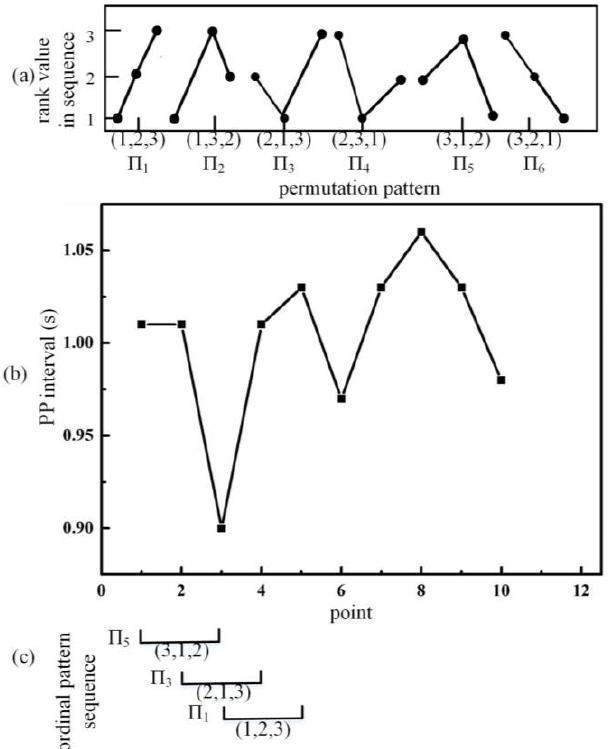
Figure 7. Schematic diagram for constructing an ordinal pattern sequence. ( a ) all possible ordinal patterns, ( b ) PP interval series, ( c ) corresponding ordinal patterns.